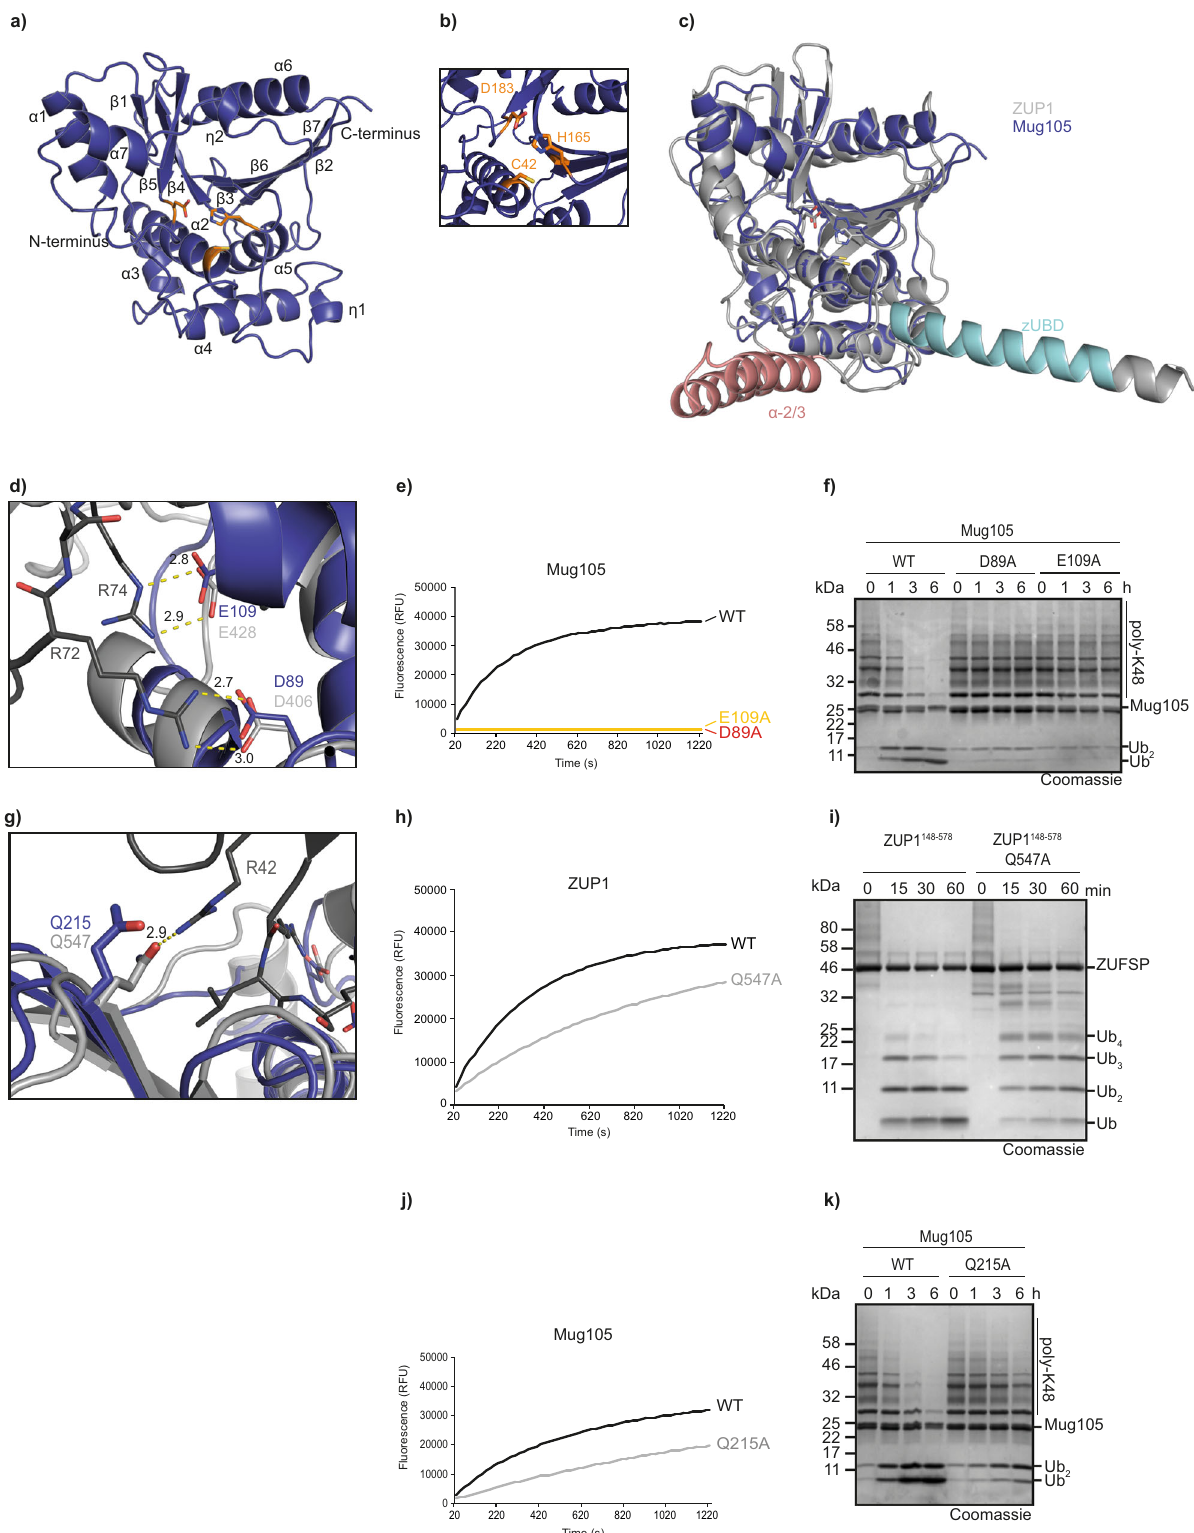
the Q547A mutant showed a moderate decrease in cleavage activity (Fig. 1h, i). In Mug105, the corresponding residue is Gln- 215 (Fig. 1g). The analogous Q215A mutation in Mug105 shows a reduced activity against the RLRGG-AMC peptide (Fig. 1j) and against K48 chains (Fig. 1k). Since the recognition of the ubiquitin-derived peptide should be independent of